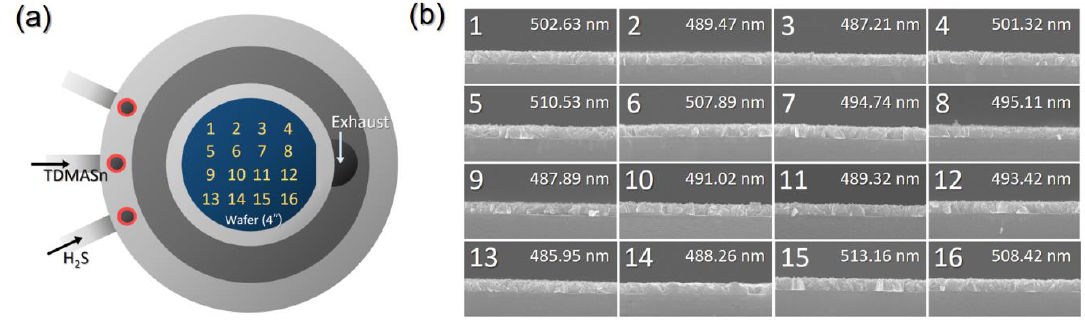
Figure 4. ( a ) Schematic image of a showerhead-type atomic layer deposition (ALD) chamber used in this study. ( b ) SEM images of 16 points on four-inch scale wafer for uniformity testing of the SnS film process.